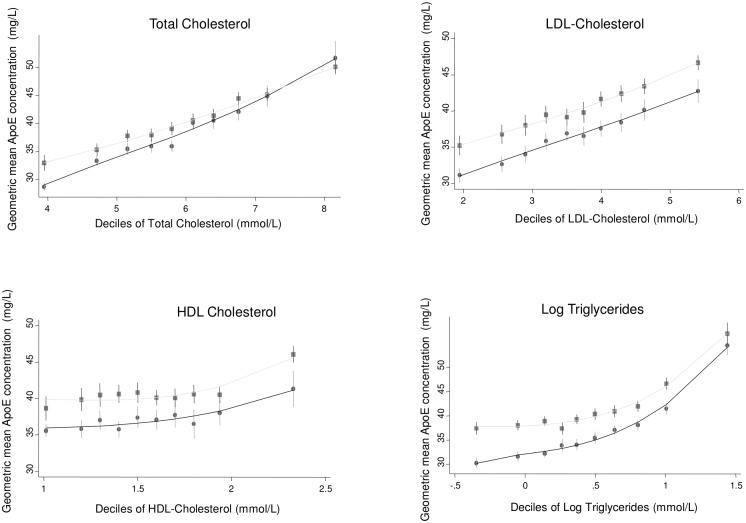
Cross-sectional association between geometric mean of ApoE concentration and total cholesterol, low-density lipoprotein cholesterol, high-density lipoprotein cholesterol, and triglycerides measured in ELSA, by gender.Male (circles) and female (square) mean log ApoE concentration was calculated for each decile of the associated variable and plotted to visualise the shape of the association. Bars give 95% CIs.